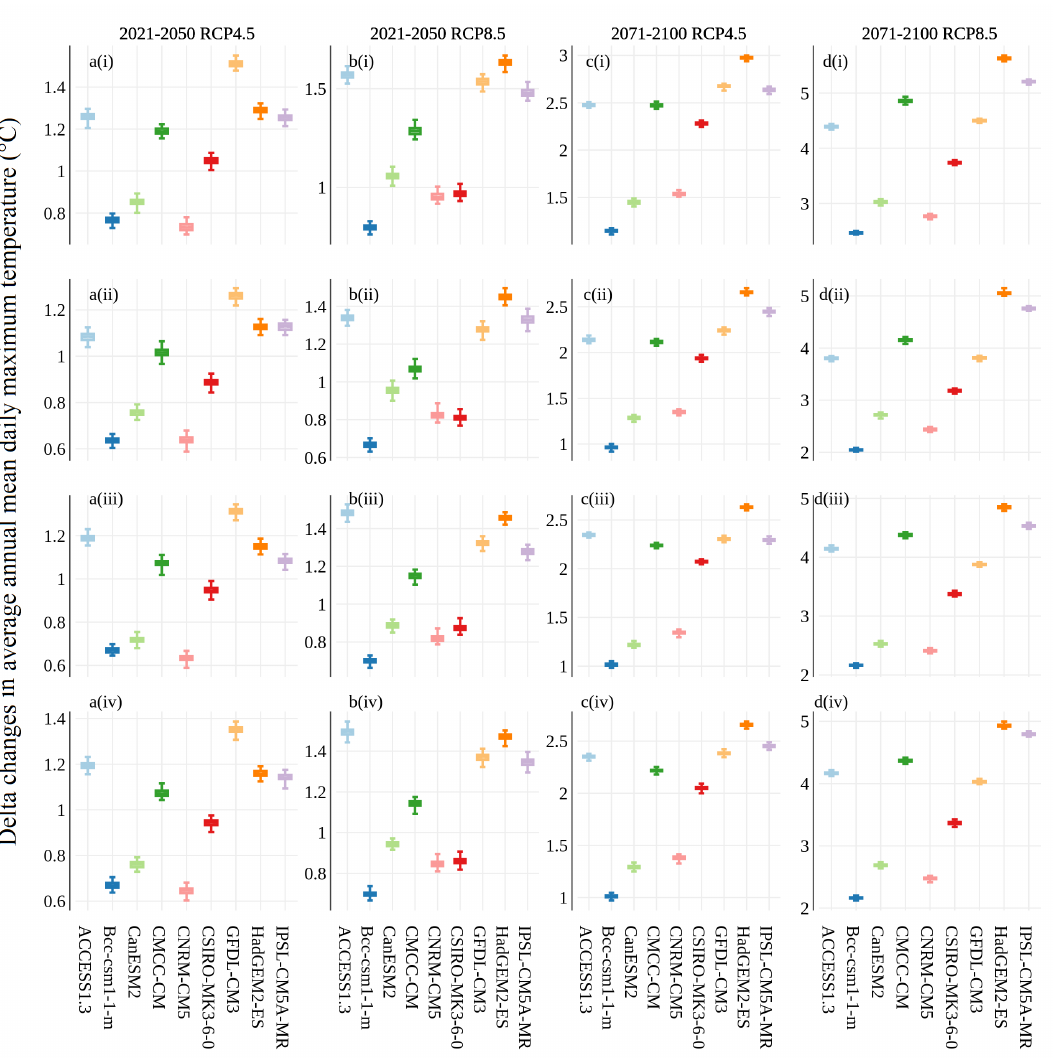
Figure 7. Delta changes in long-term average annual mean daily maximum temperature from downscaled GCM data for: ( a ) 2021–2050 period under RCP4.5 scenario; ( b ) 2021–2050 period under RCP8.5 scenario; ( c ) 2071–2100 period under RCP4.5 scenario; and ( d ) 2071–2100 period under